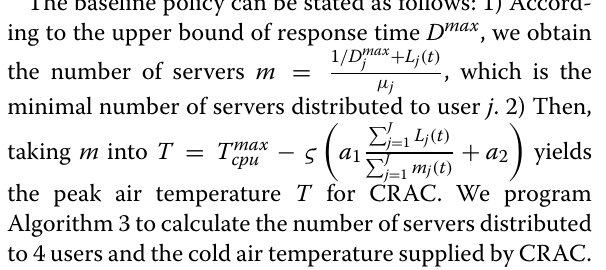
Algorithm 3 to calculate the number of servers distributed